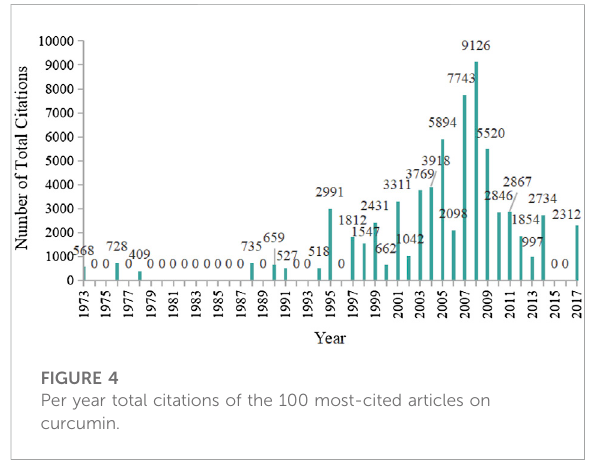
FIGURE 4 Per year total citations of the 100 most-cited articles on curcumin.